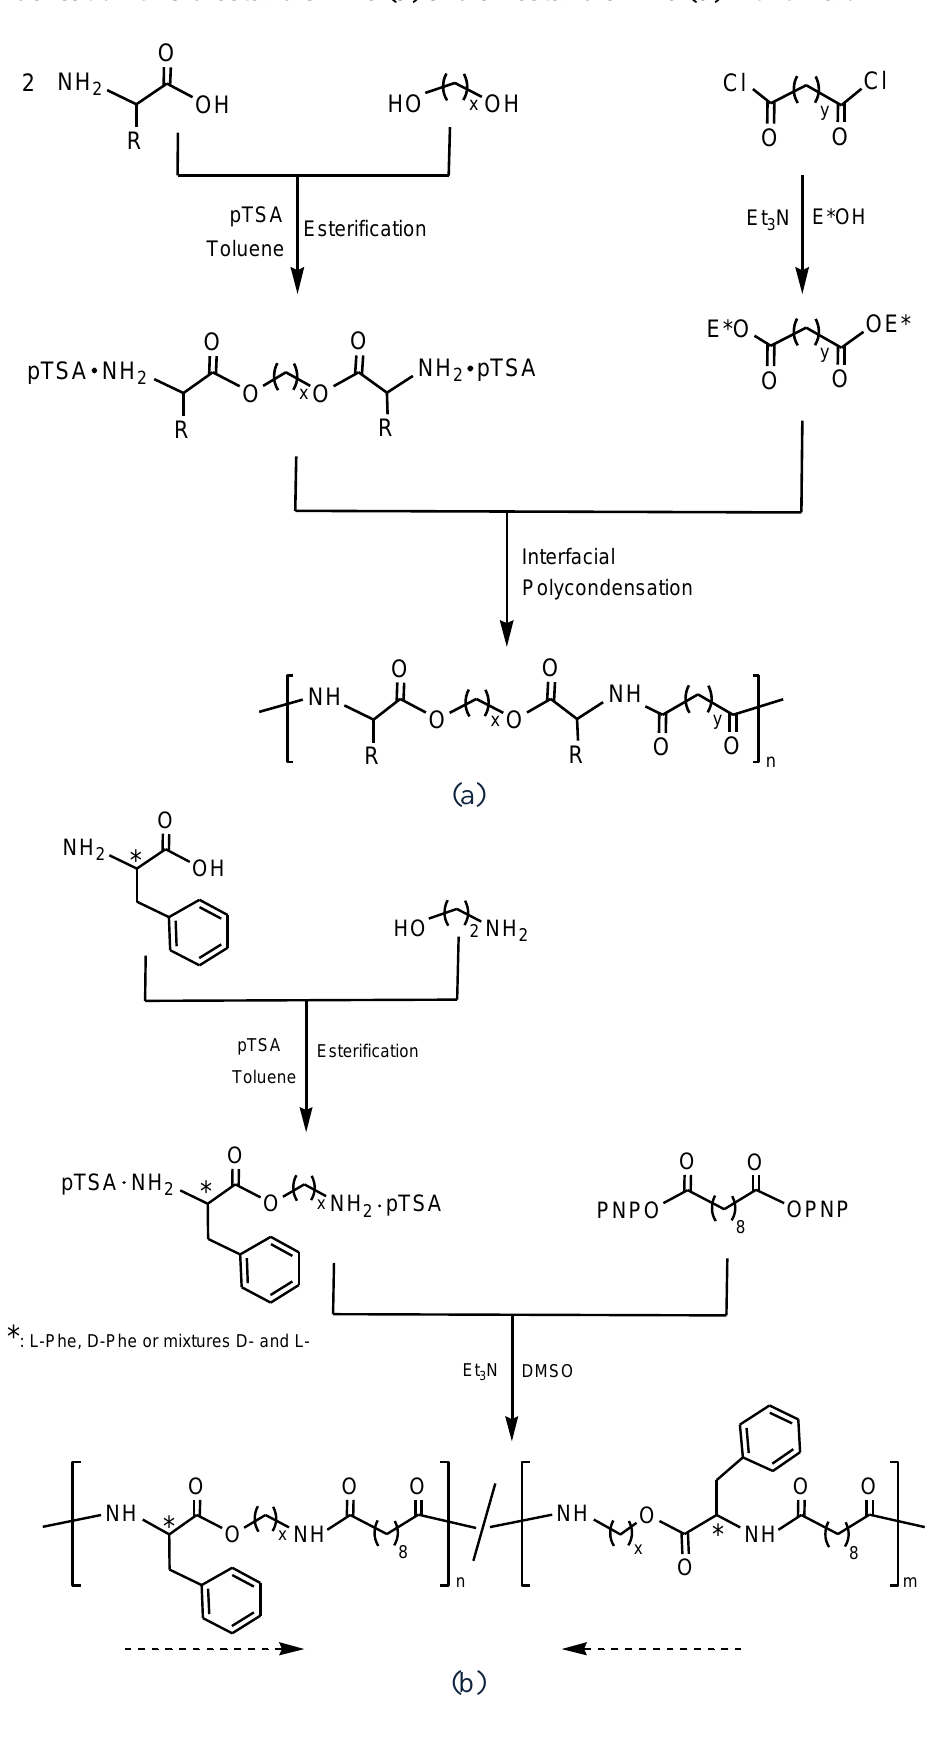
Figure 6. Poly(ester amide)s incorporating  -amino acids prepared by solution polycondensation of a diester-diamine ( a ) and an ester-diamine ( b )